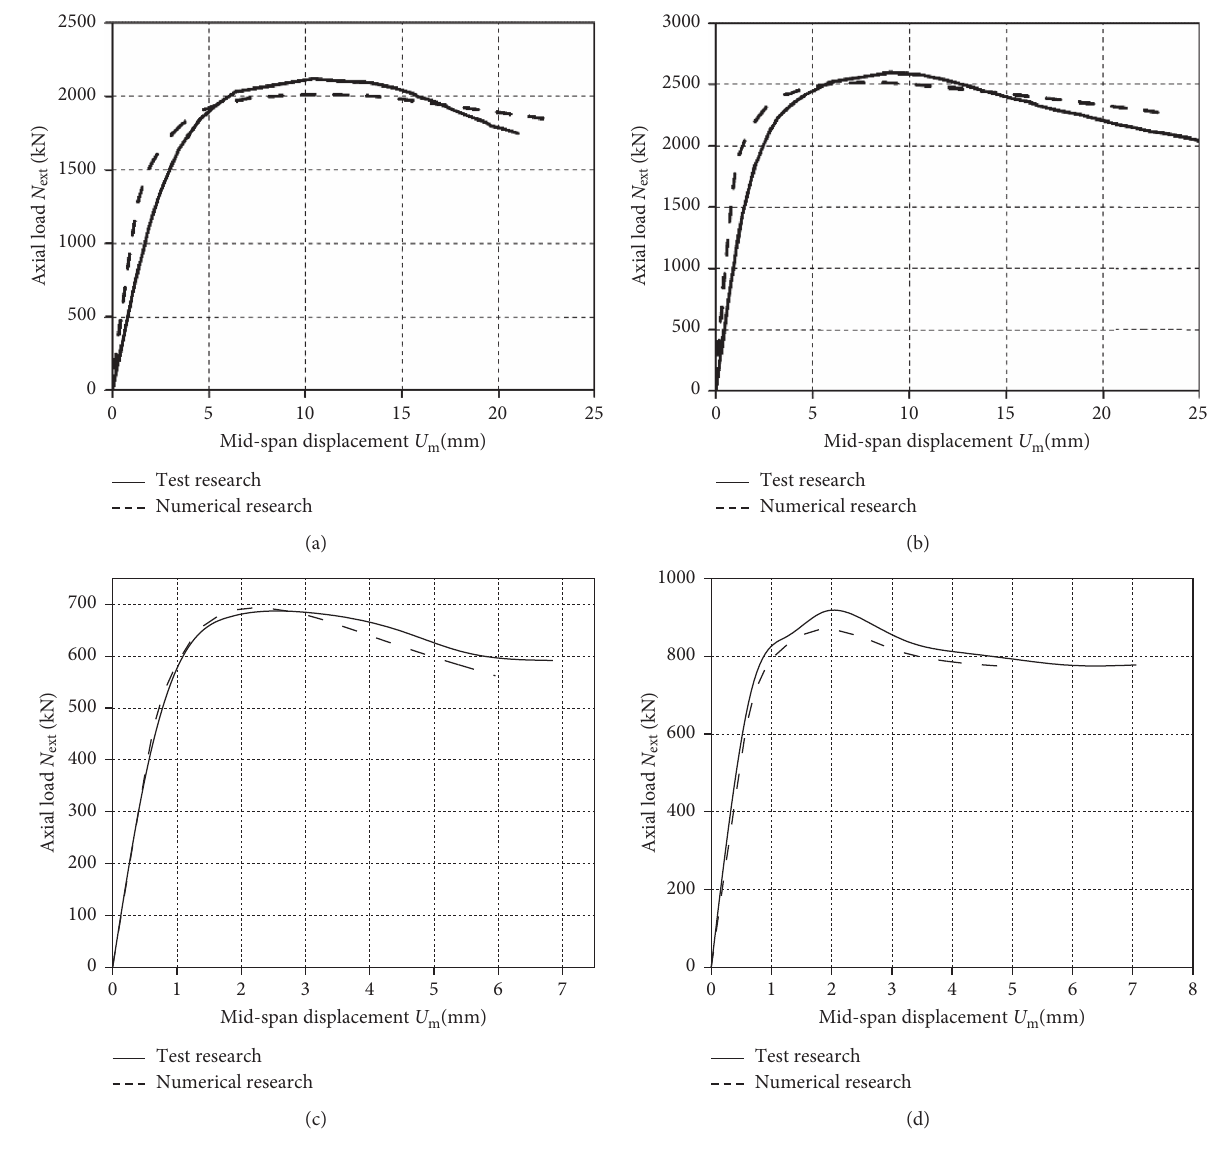
Figure 6: Comparison of numerical curves and test curves. (a) TE5. (b) TE6. (c) B20-180. (d)